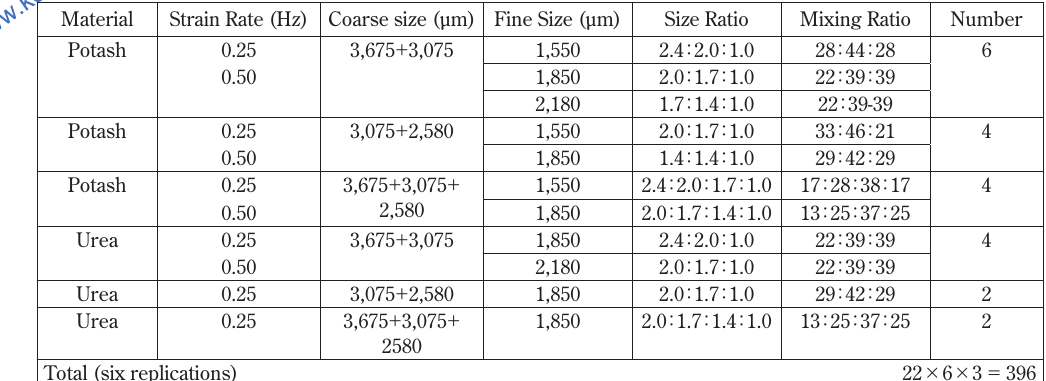
Table 2 Experimental design for multi-size mixtures for potash and urea * Material